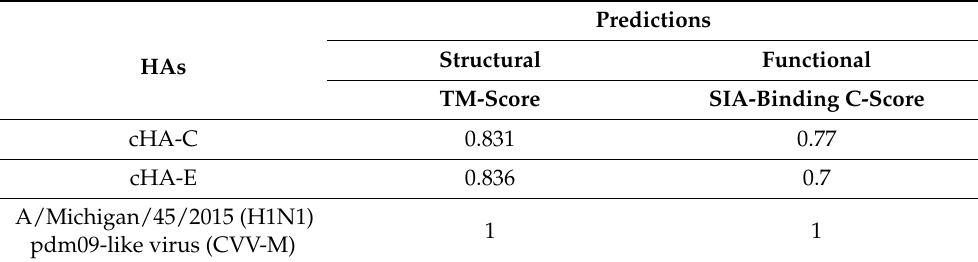
Table 1. Structural and functional predictions.